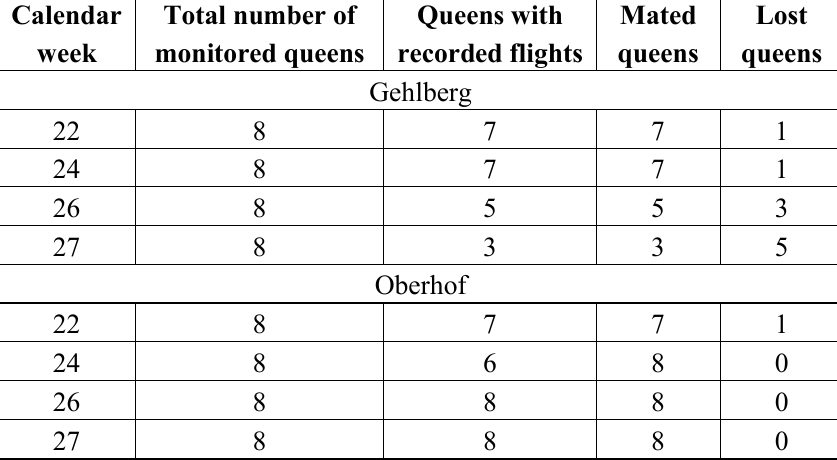
Table 3. Number of queens with recorded nuptial flights, number of mated (queens which started egg laying) and lost queens (queens which did not return from the mating station) for each location and experiment week. Two of the mated queens were not recorded at